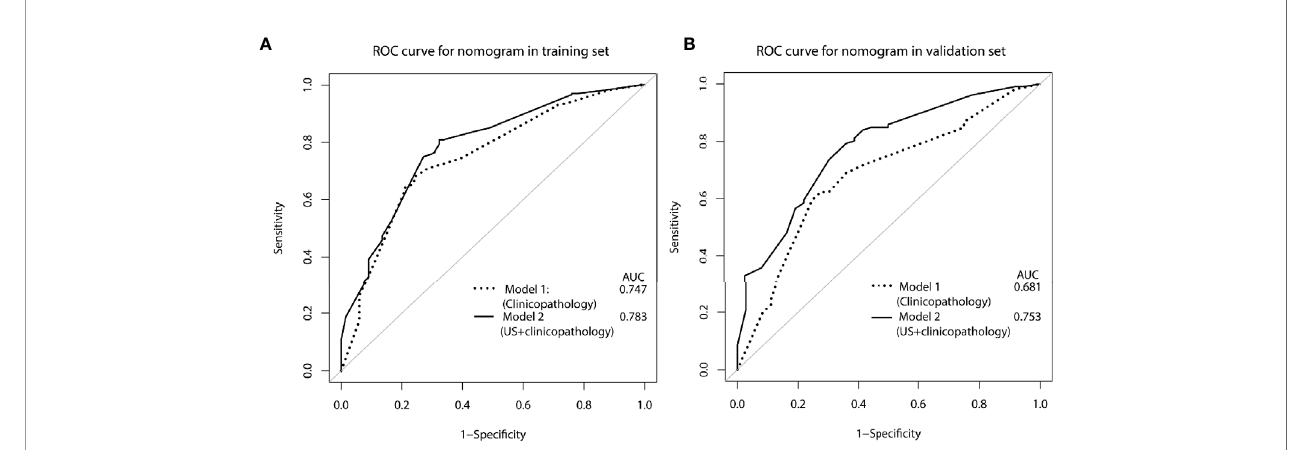
FIGURE 4 | ROC curve for predicting ADH upgrades: (A) in the training set, (B) in the validation set. Model 1, clinicopathological features; Model 2, US +clinicopathological